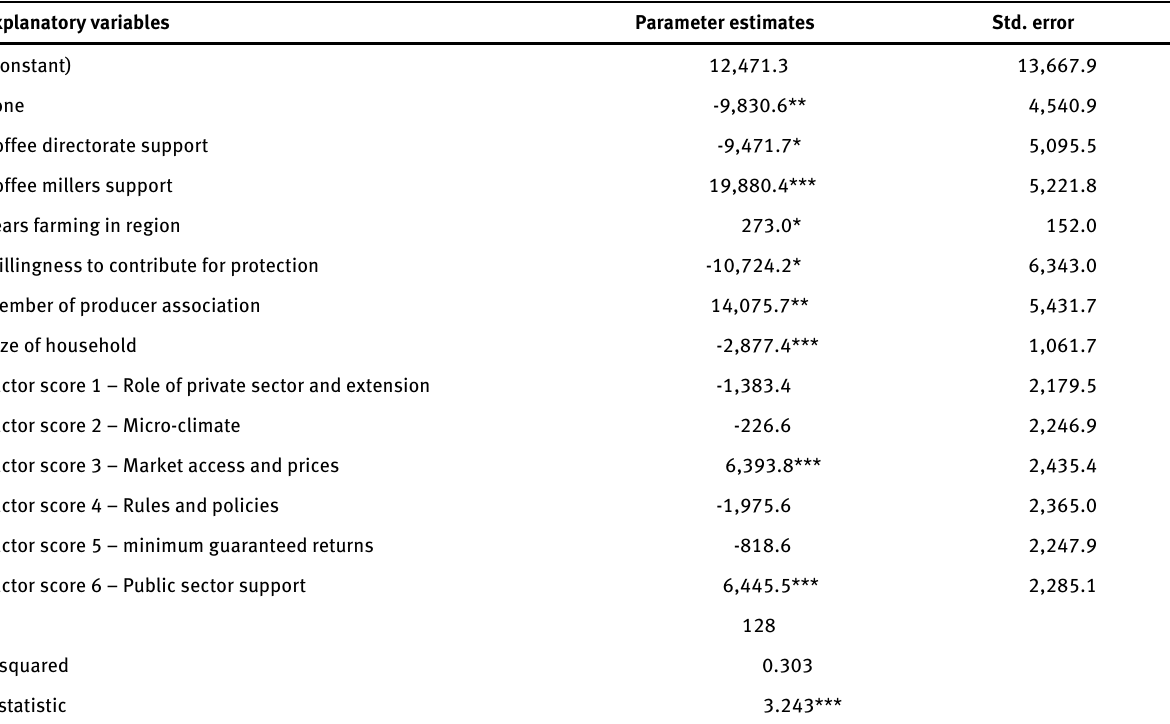
Table 3: Regression parameter estimates for coffee producers’ profit Explanatory variables